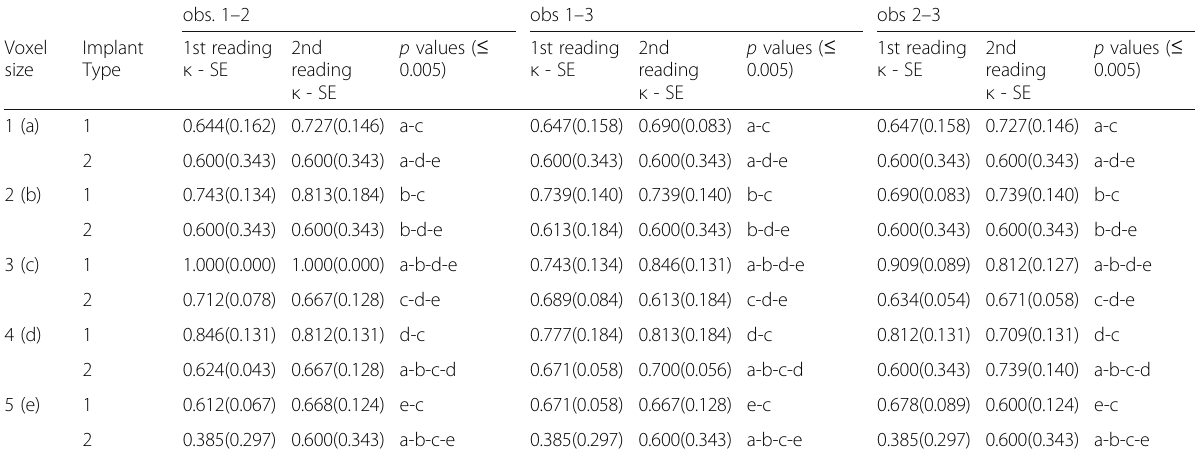
Table 2 Inter-observer kappa coefficients value and standard error according to scan modes and implant types for 1st and